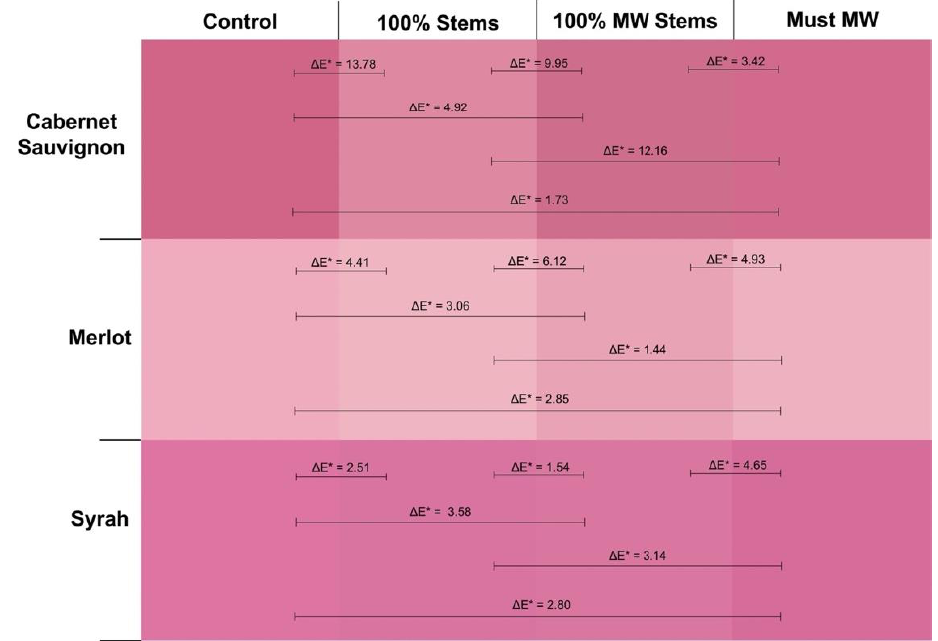
Figure 2. Visual depiction of the actual color of the 2016 wines of the three cvs. and four winemaking treatments as seen through a 1 mm path length quartz cuvette at the time of pressing (day 12). ΔE* values are shown between each pair of treatments for a given cv.